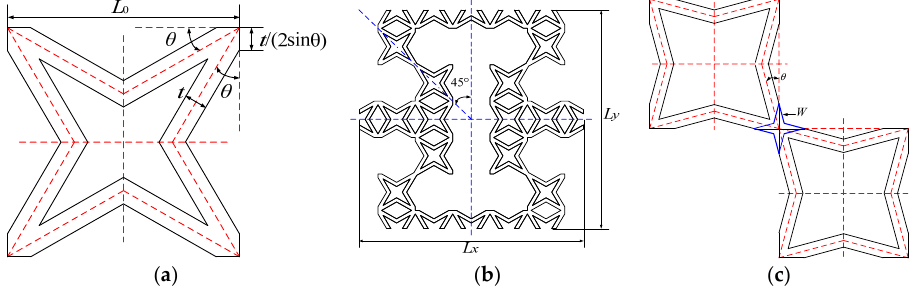
Figure 1. Geometry of the novel star-re-entrant hierarchical metamaterial: ( a ) star subordinate cell, ( b ) re-entrant representative unit cell, ( c ) the jointing between two neighboring stars.